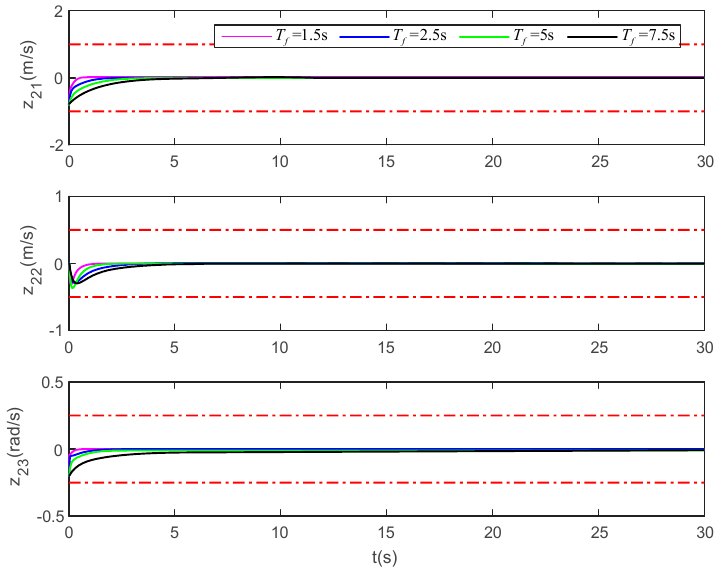
Figure 21. Pose tracking error of the vessel under different settling time. (The upper and lower red dotted lines are error constraint boundaries).